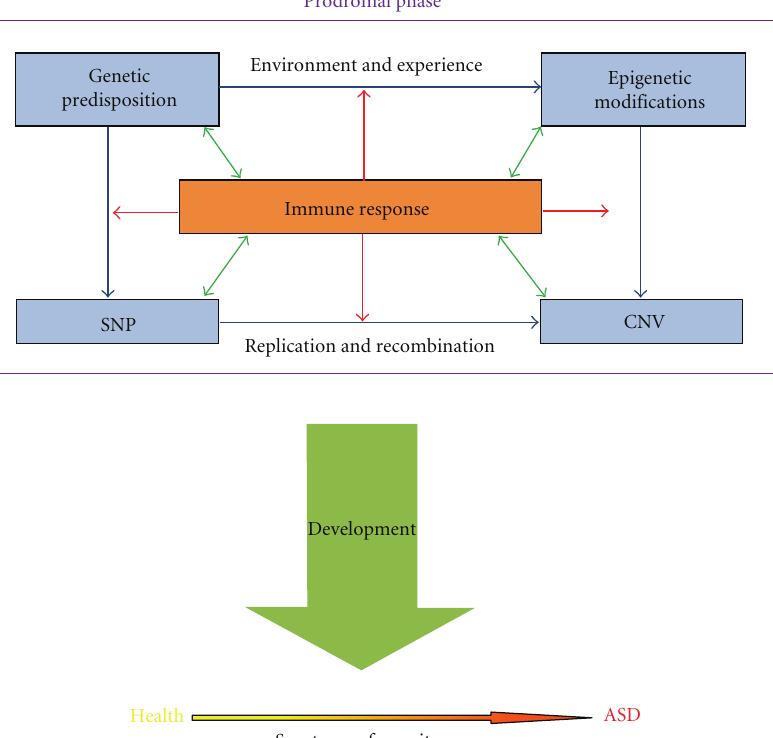
Figure 1: Hypothetical model linking genetic/genomic mutation to autism spectrum disorder through endogenous mechanisms of the immune